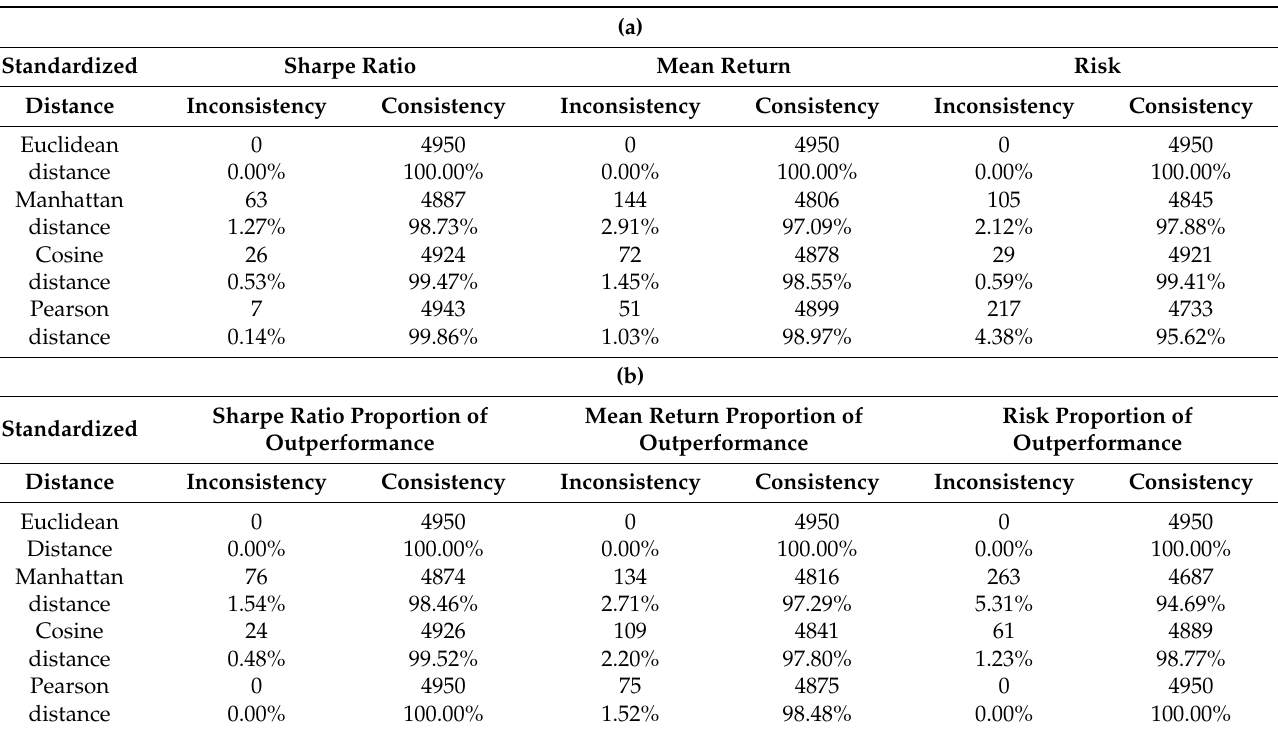
Table 5. Multiple t -test results. (a) Investment performance comparison; (b) Proportion of outperfor- mance comparison.